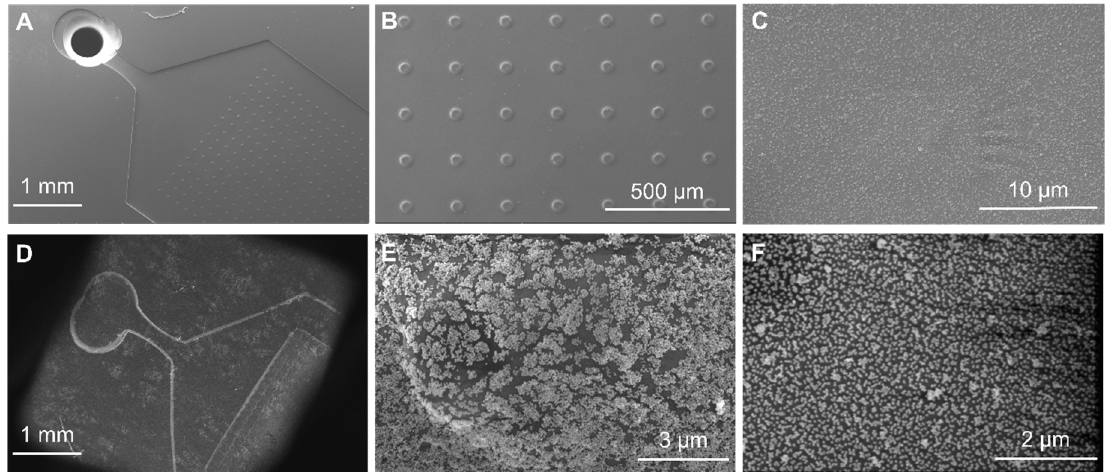
Figure 4. SEM images of the assembled GNSs after system de-bonding at different magnifications on the PDMS part ( A – C ) and on the paper substrate ( D – F ).